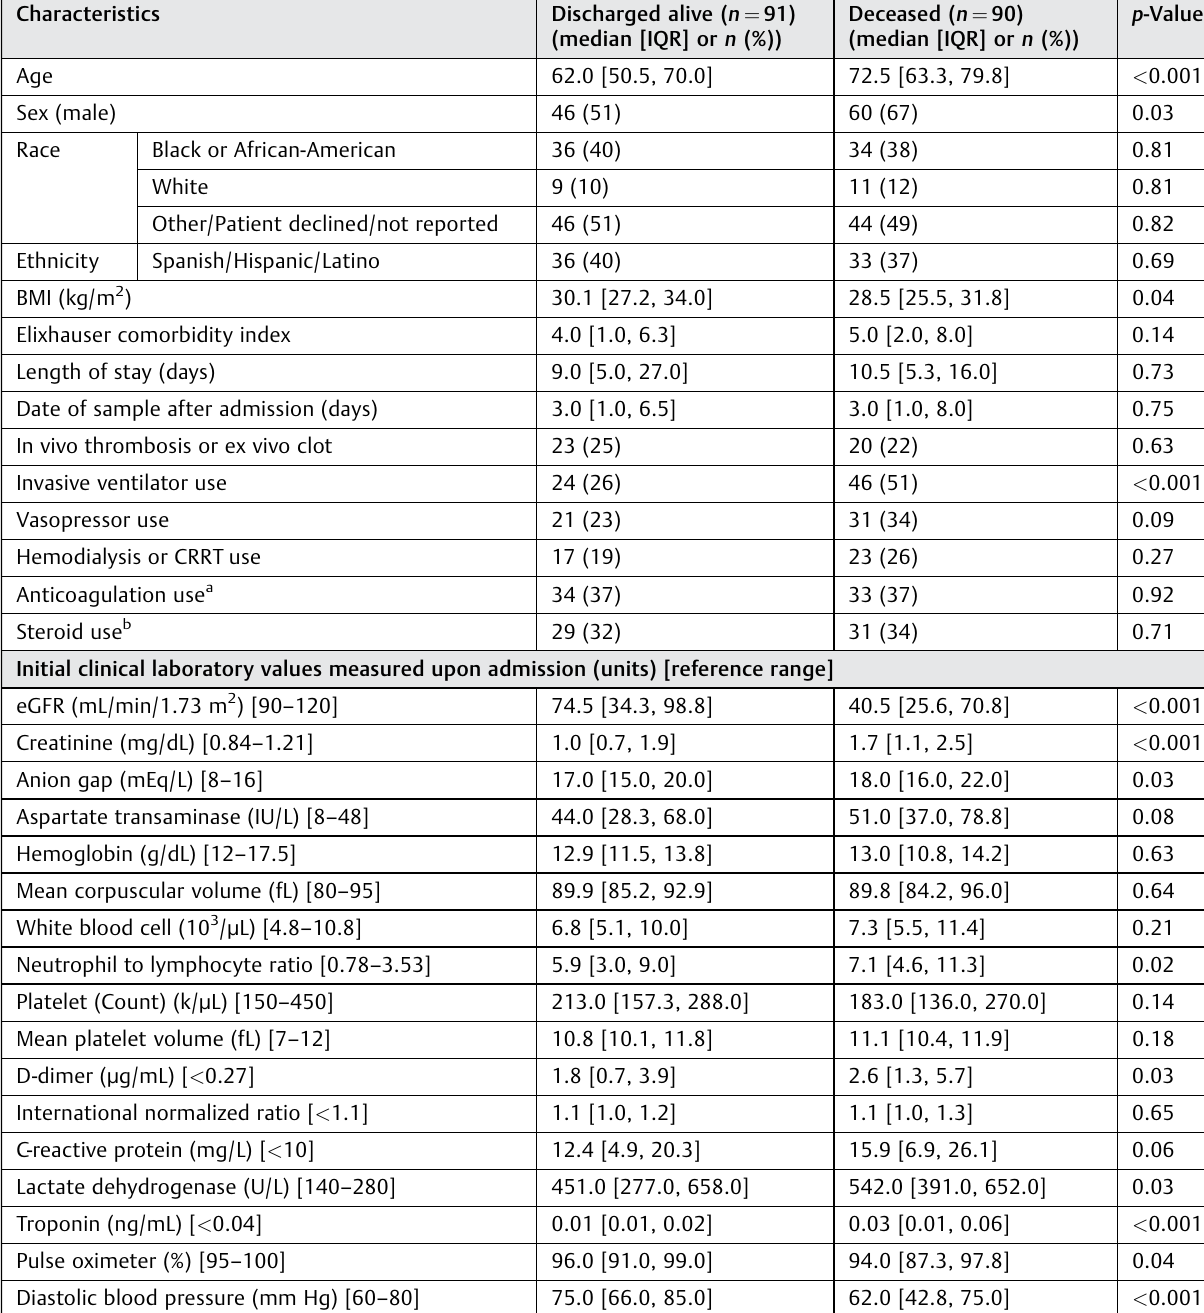
Table 1 Characteristics and initial clinical laboratory data of 181 patients with COVID-19 strati fi ed by mortality outcome